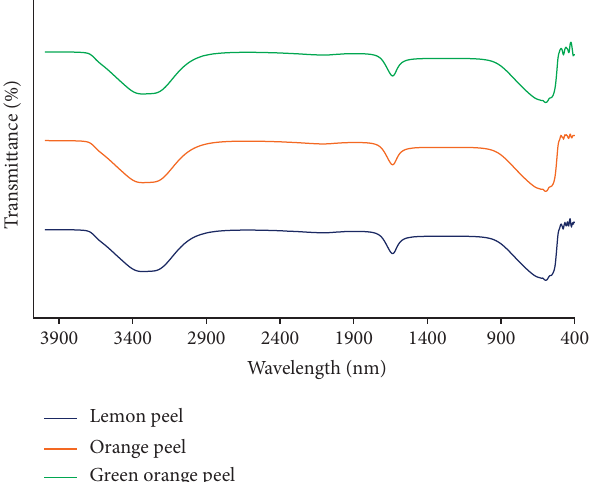
Figure 3: FT-IR spectrum of silver nanoparticles synthesised using lemon peel, orange peel, and green orange peel